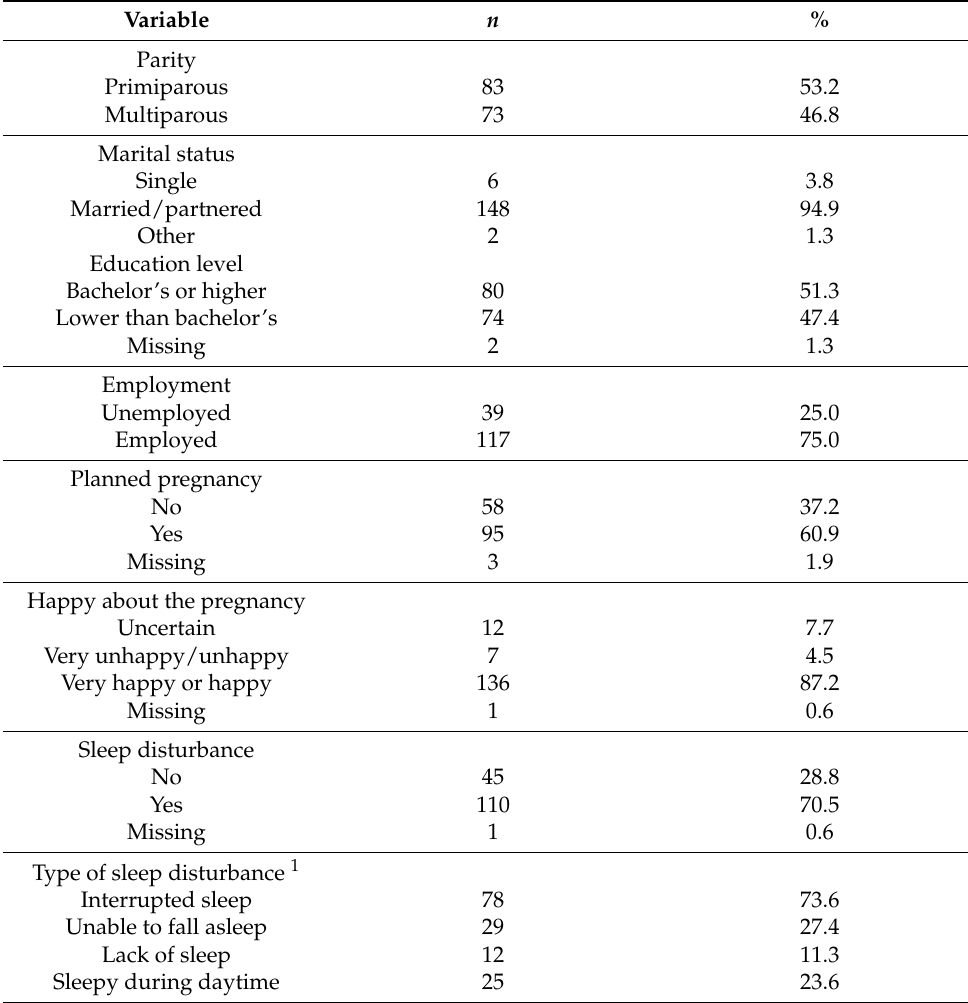
Table 1. Demographic information of the participants at Time 1 ( n =